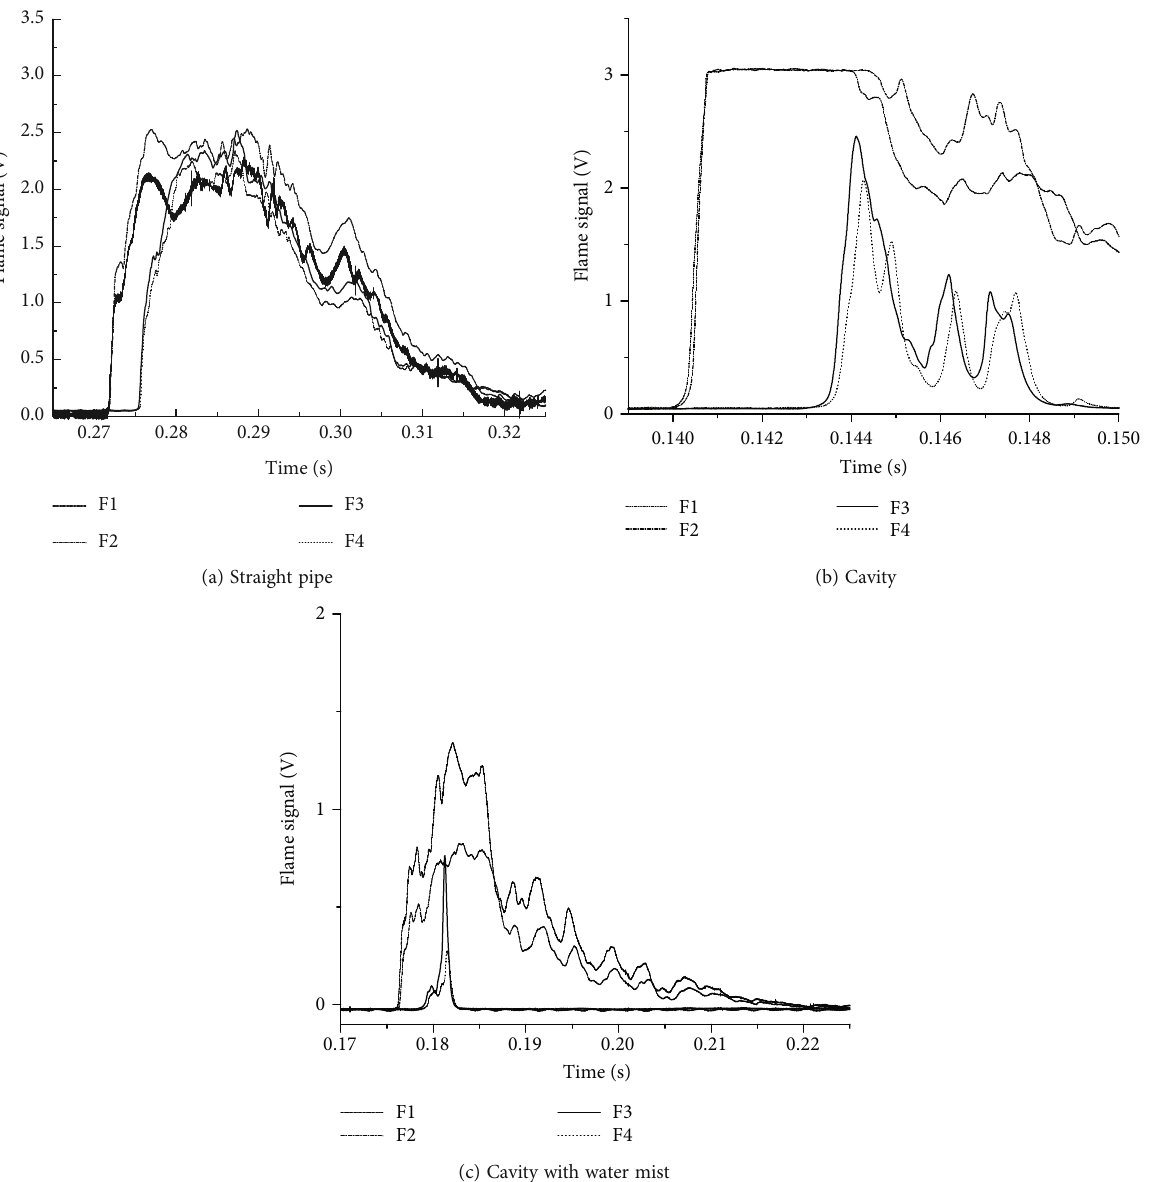
Figure 6: Explosion fl ame velocity signal information of measuring points F 1 , F 2 , F 3 , and F 4 under di ff erent working